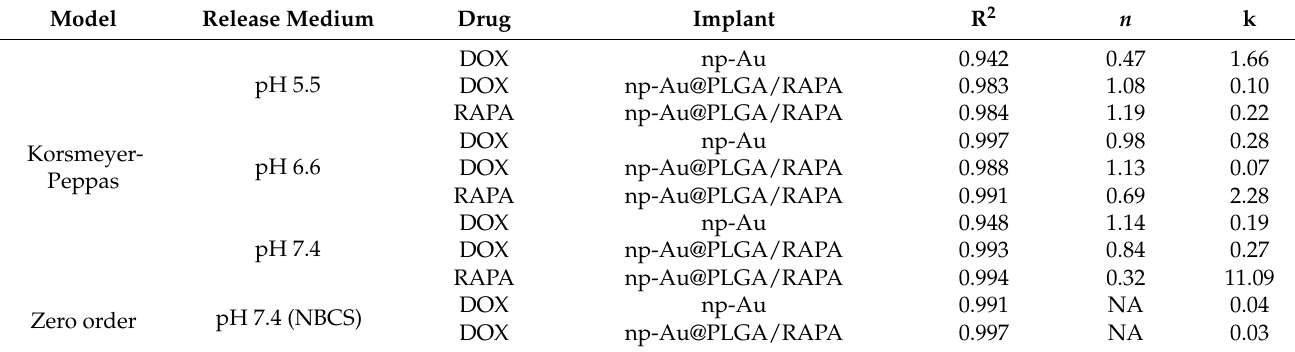
Table 1. Kinetic parameters for DOX/RAPA release from np-Au-based